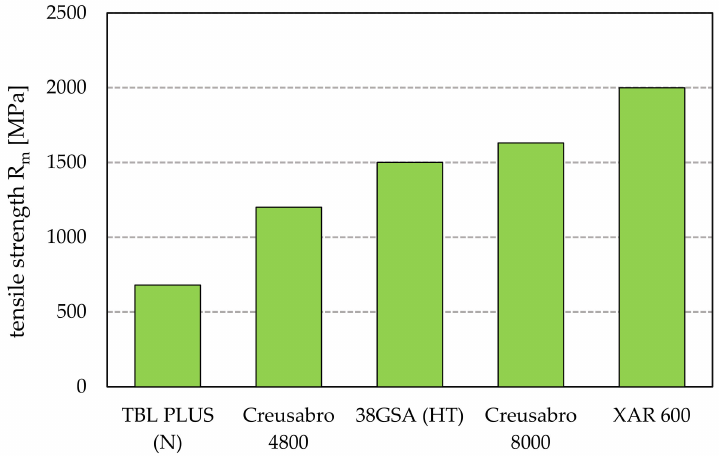
Figure 2. Tensile strength R m of the tested types of steels based on manufacturer’s data. N—as-normalized condition, HT—as-hardened condition